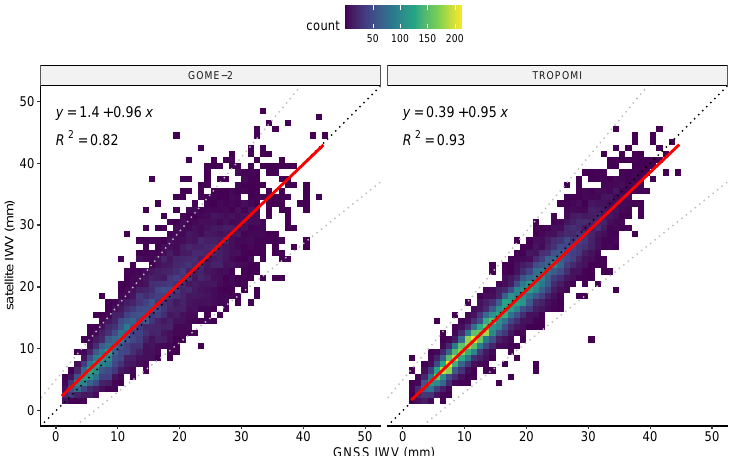
Figure 2. Scatterplot of GOME-2 ( left ) and TROPOMI ( right ) IWV vs. GNSS IWV. Dotted, grey lines show the 20 % error ( ± 5 mm); the dotted, black line is the ideal 1:1 line; and the red, solid line is the linear fit.